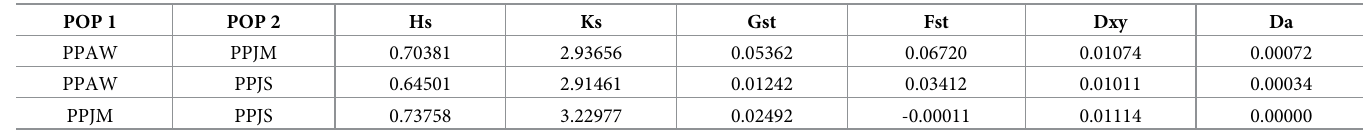
Table 3. PpSP12 pairwise comparisons of genetic differentiation estimates.